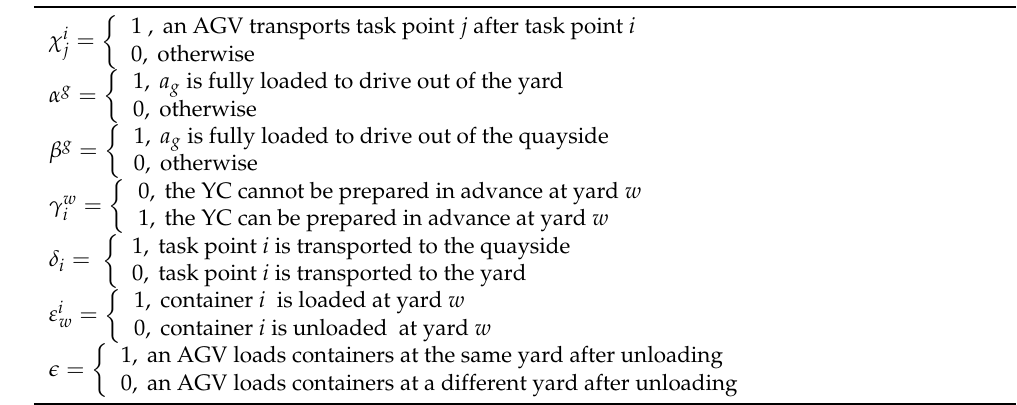
Table 4. The decision variables and their